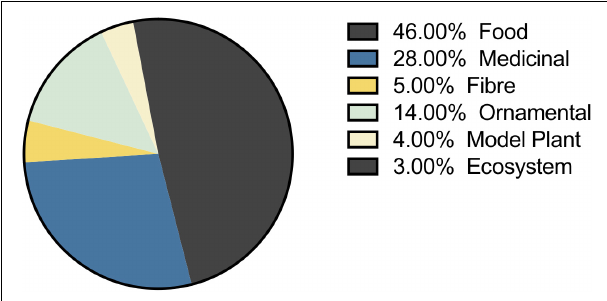
FIGURE 7 | Selection of plant species for melatonin studies is largely driven by economic value. Where species can fit two categories the primary use was included for